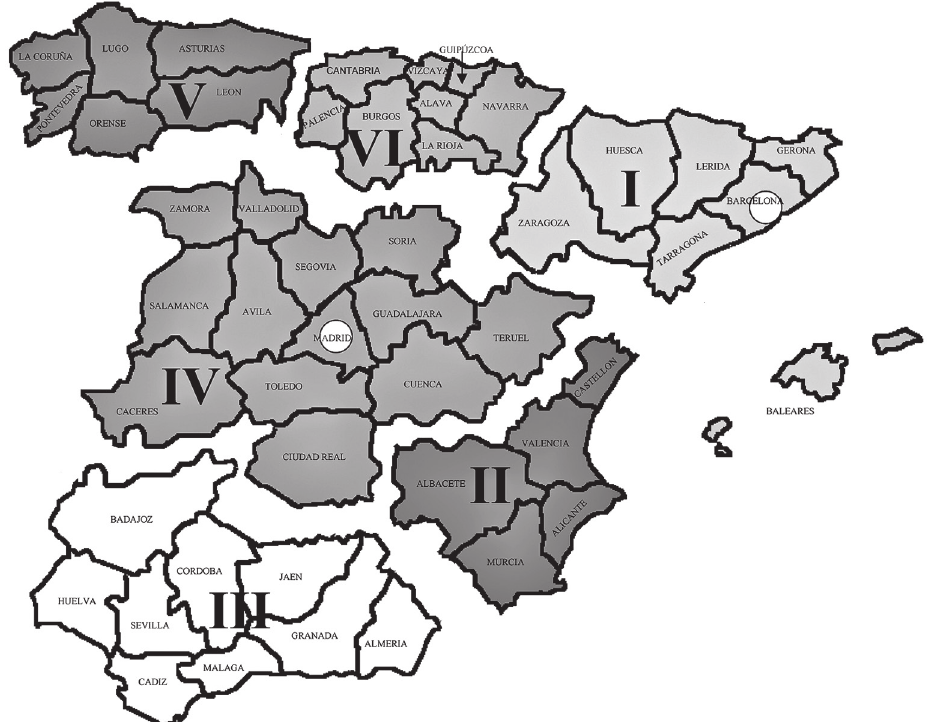
Fig. 2. Map of Spanish Nielsen geographical areas. Source : Own